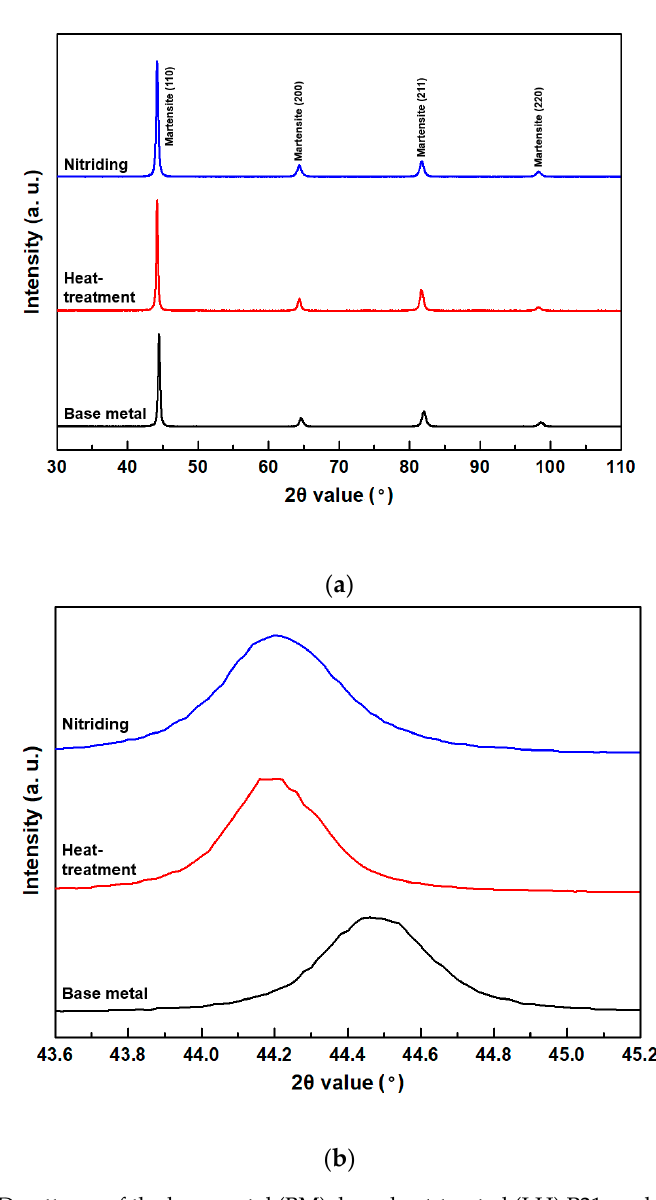
Figure 4. ( a ) XRD patterns of the base metal (BM), laser heat-treated (LH) P21, and laser nitrided (LN) P21. ( b ) Magnified (110) plane XRD peak.